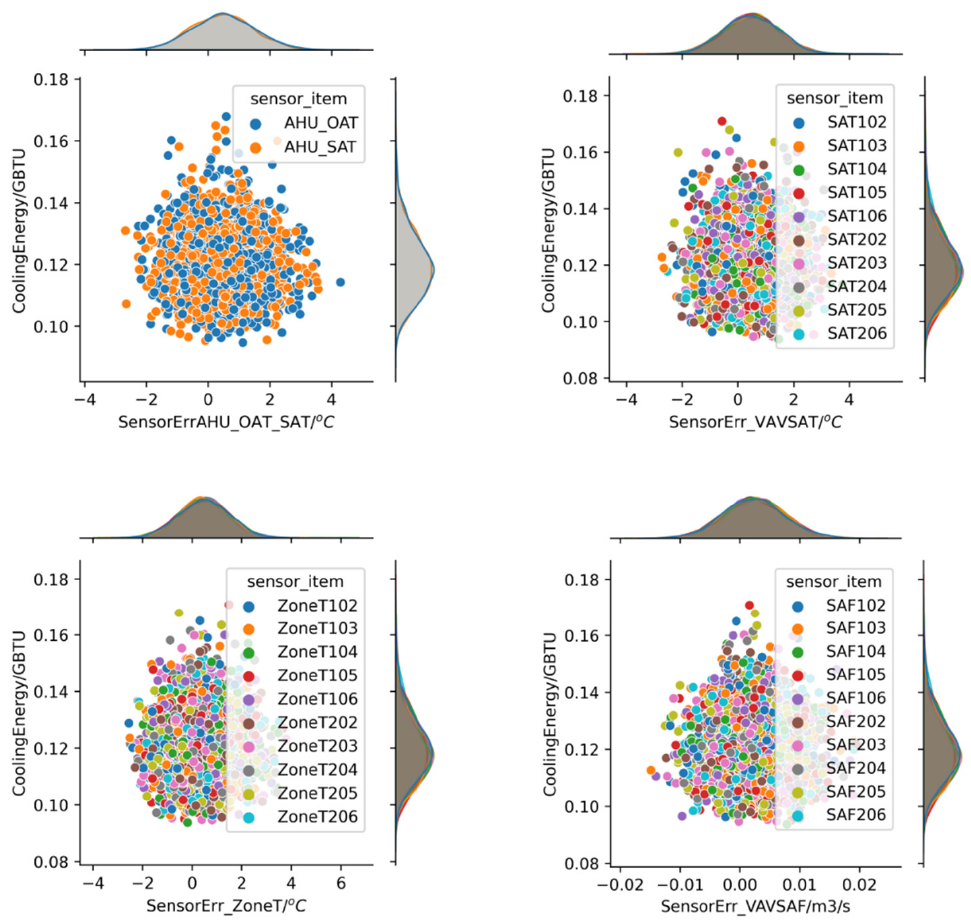
Figure 14. Cooling energy and sensor errors. Figure 15 shows the total fan energy consumption with averaged sensor error distribu- tions. The top left shows the AHU OAT and SAT sensor errors with fan energy consump- tion. The top right shows the VAV box SAT sensor errors with fan energy consumption. The bottom left shows the zone temperature sensor errors with fan energy consumption. The bottom right shows the VAV box SAF sensor errors with fan energy consumption. From the distributions, the sensor errors show normal distributions instead of a linear relationship. The fan energy consumption was 50,501~53,900 kBtu/year based on the distribution of sensor total errors. The change of total fan energy consumption was 3399 kBtu/year, which is 6.7% of the baseline fan energy consumption (50,422 kBtu/year). The fan energy impacts could go 0.15% lower or 6.9% higher, compared with